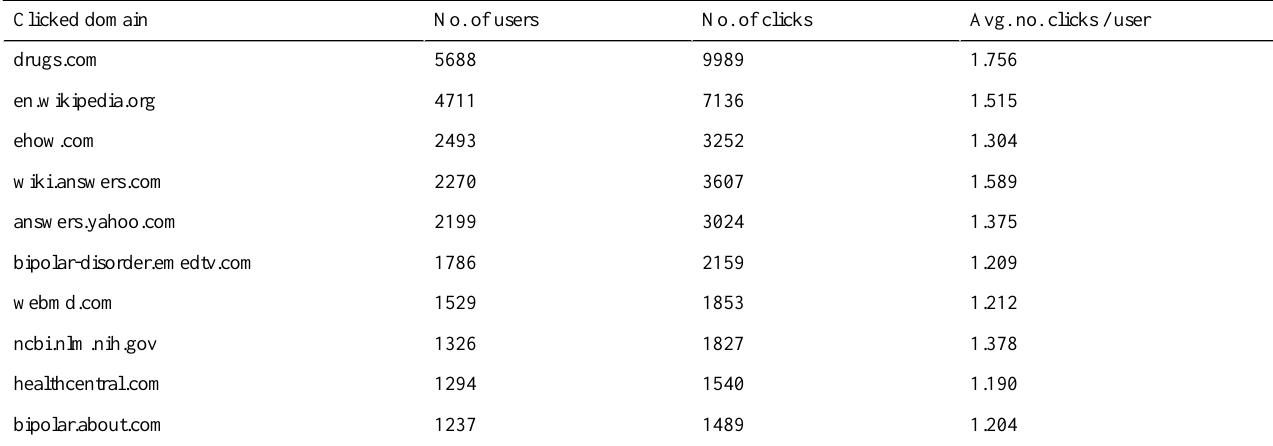
Table 2. Top 10 clicked URLs following MD medication